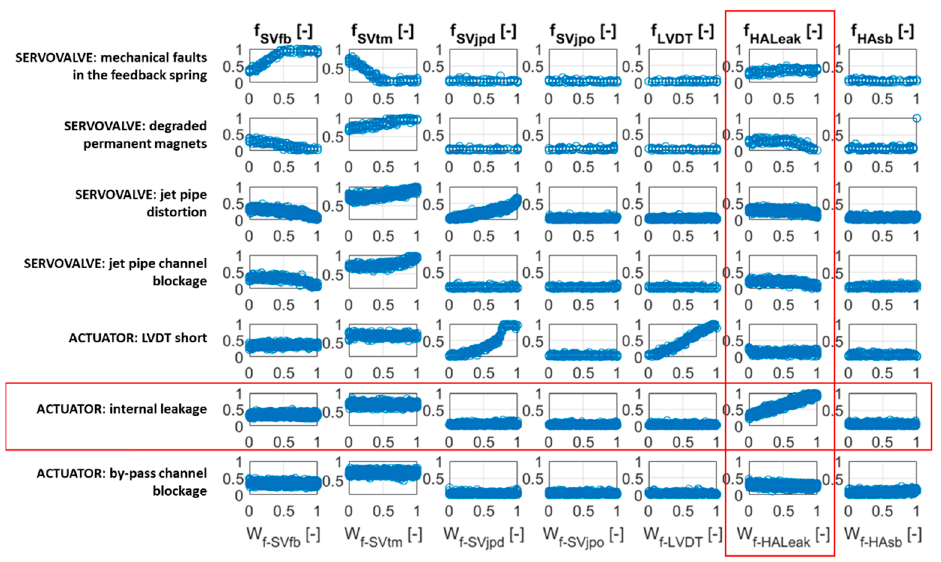
Figure 5. Features behavior on simulated